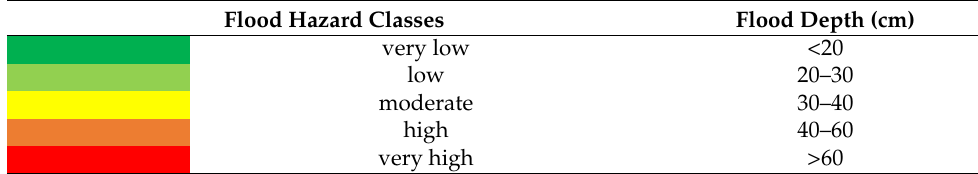
Table 2. Qualitative range of flood hazard classes. Flood Hazard Classes Flood Depth